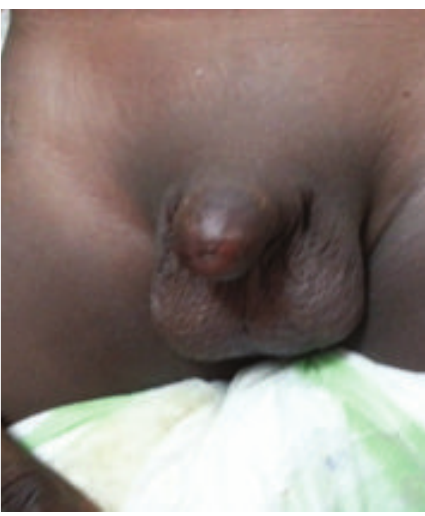
Figure 1: Total glans penis amputation with meatal stenosis from scarring.